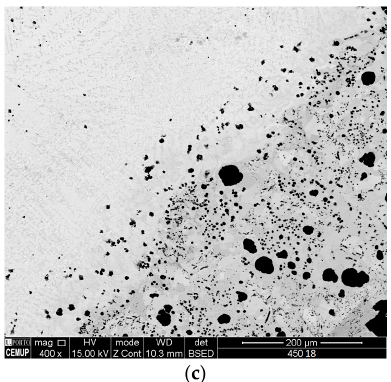
Figure 11. SEM analysis of samples at 400× magnification with 4% Nital etching: ( a ) sample 14_P300_N